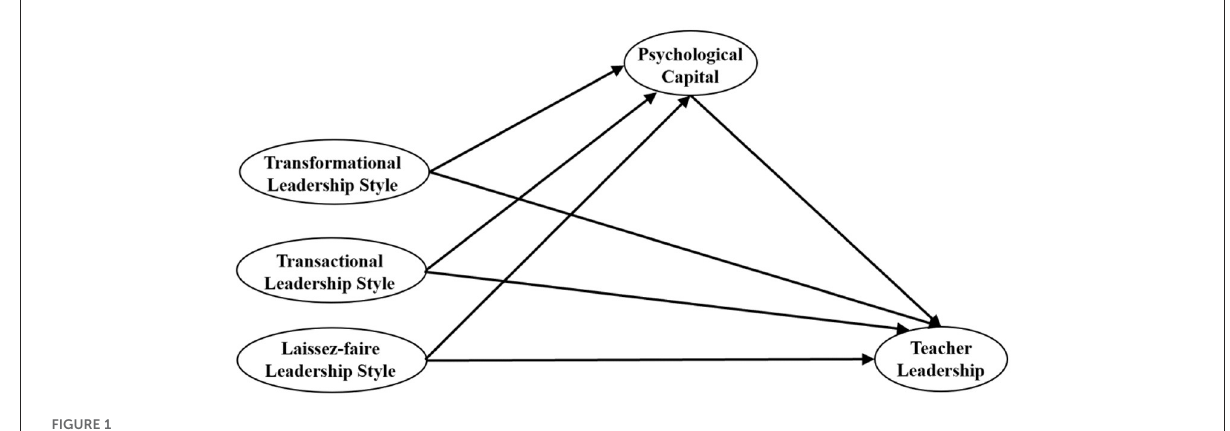
FIGURE1 Hypothetical